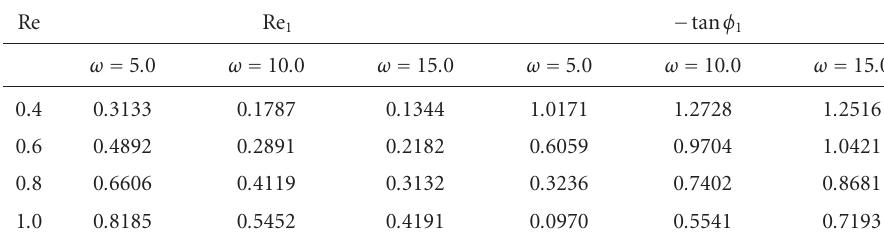
Table 4.2. Shear stress due to main flow.